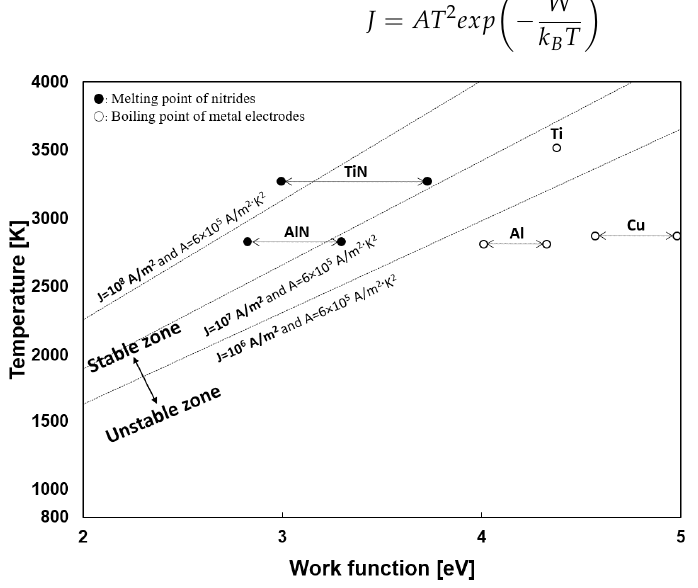
Figure 19. Linear function of minimum current density for stable arc discharge and the relationship between temperature and work function. During the Ti 30 A experiment, the tip of both electrodes turned golden yellow, which is the appearance color of TiN, suggesting the tip of the Ti electrode was composed of TiN. In Figure 19, TiN requires a less work function than Ti, i.e., TiN requires less en- ergy to emitting thermion than Ti. In other words, TiN can initiate arc discharge at a lower temperature than Ti. This was the reason why the Ti electrode provided sustainable arc discharge for the particle preparation process. A similar discharge behavior was observed in the initial stage of the Al 30 A experi- ment. The white-to-pale-yellow AlN particles covered both electrodes were observed. However, as Al has a low melting point (933 K), the heated anode started melting drasti- cally and hindered AlN formation’s effect on the cathode tip. When the melting started, the gap distance was hard to manage, causing the arc discharge to be maintained only for a few seconds. It can be concluded that the stability of the arc discharge is affected by the cathode temperature, work function, and thermal properties of the electrode materials. 5. Conclusions The submerged arc discharge process was used to synthesize nitride particles in liq- uid nitrogen. Changing current as an experimental parameter was used to investigate the properties of prepared particles. Using Ti and Al electrodes, TiN and AlN particles were successfully synthesized directly from metal electrodes. Particles prepared with a Cu elec- trode had a metallic Cu phase. When applying high-power mode, the crystallinity of the nitride peaks increased, which implied that the current influenced the crystallinity of syn- thesized particles. According to the experimental results of different metal electrode com- binations, it was confirmed that the anode generates most of the particles in this process. Based on the results, the particle generation mechanism was proposed. The proposed par- ticle preparation process using arc discharge in liquid nitrogen showed potential for a simple preparation process of nitride fine particles.